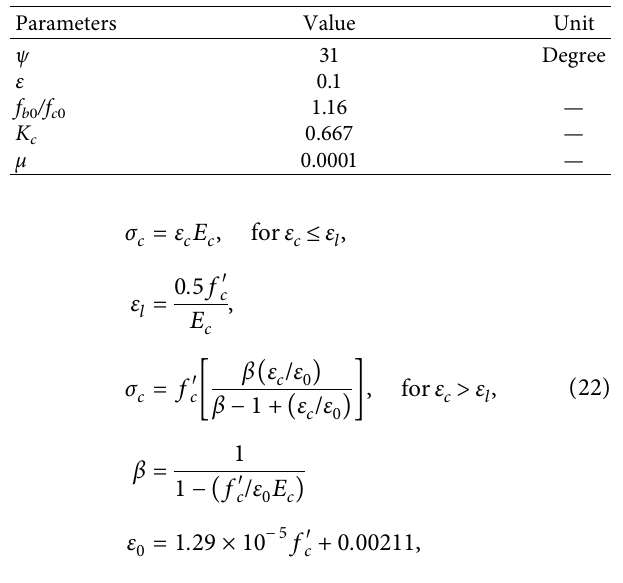
Figure 2: Strain distribution and resultant forces for an 8-column TLWD under (a) pure bending, (b) tension-controlled, (c) compression- controlled, and (d) balanced compression and tension. Table 1: Concrete damage plasticity model